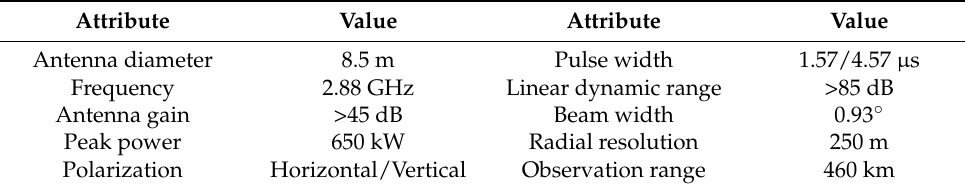
Table 2. Characteristics of the S-band dual polarization radar used in this paper.